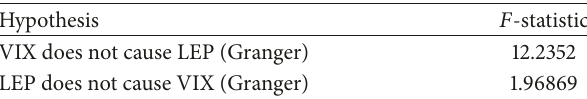
Table 4: Asymmetry perception and VIX causality test in 2012-2013.